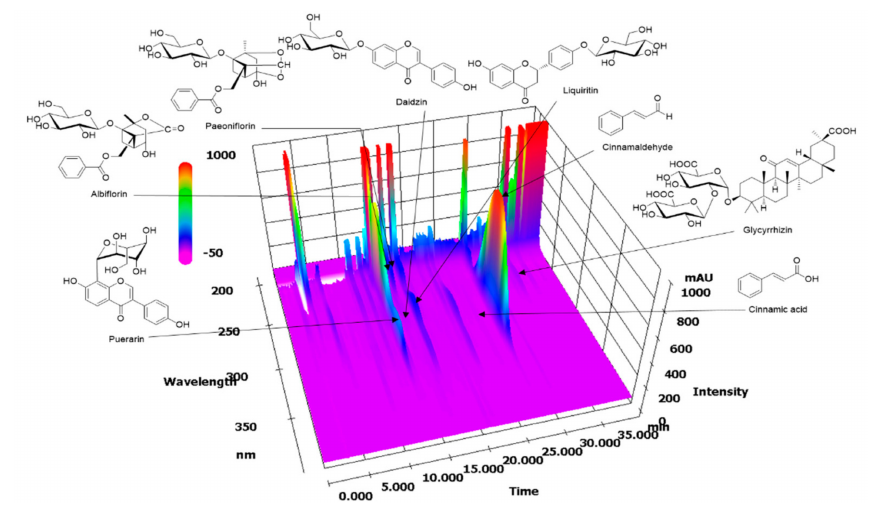
Figure 1. Three-dimensional chromatogram of GGWE by HPLC-PDA.